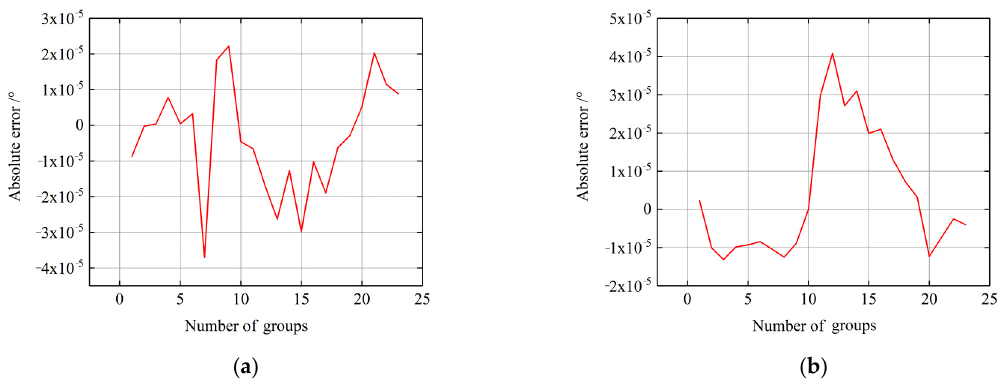
Figure 7. Error values of trajectory prediction model based on ACDE-SVR. ( a ) Longitudinal error values; ( b ) Latitudinal error values.